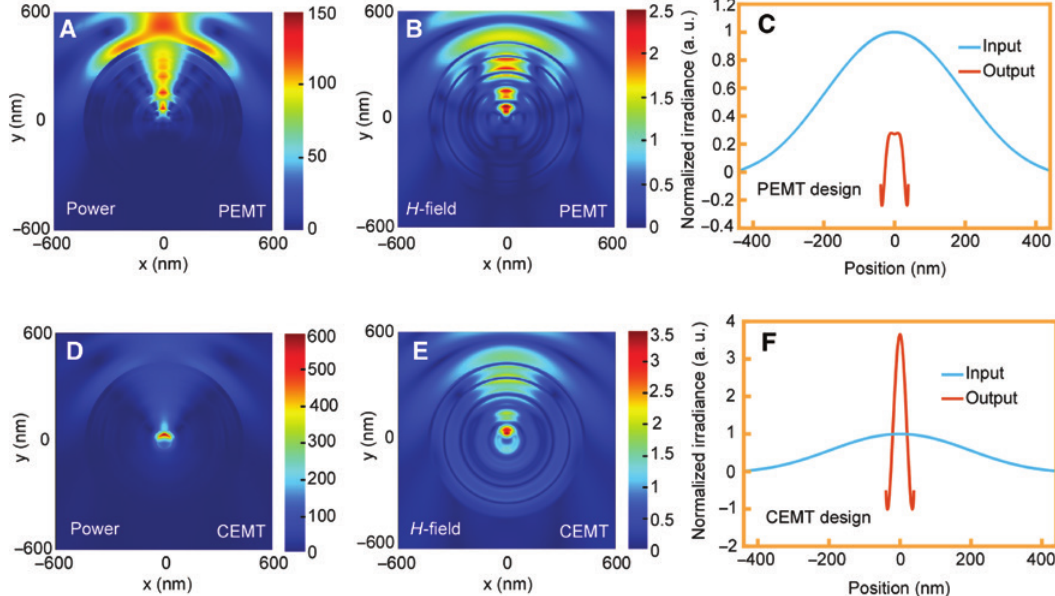
Figure 5: Full-wave field-mapping simulation of the nanofocusing device with five pairs of binary metal-dielectric layers. (A–C) PEMT or (D–F) CEMT is used for two distinct designs. (A, D) Simulated irradiances and (B, E) H -field magnitude at λ = 365 nm generated by the exact non-paraxial Gaussian beam with a waist of w = λ . (C, F) Plots of the normalized irradiance for the nanofocusing device with five pairs of binary metal-dielectric